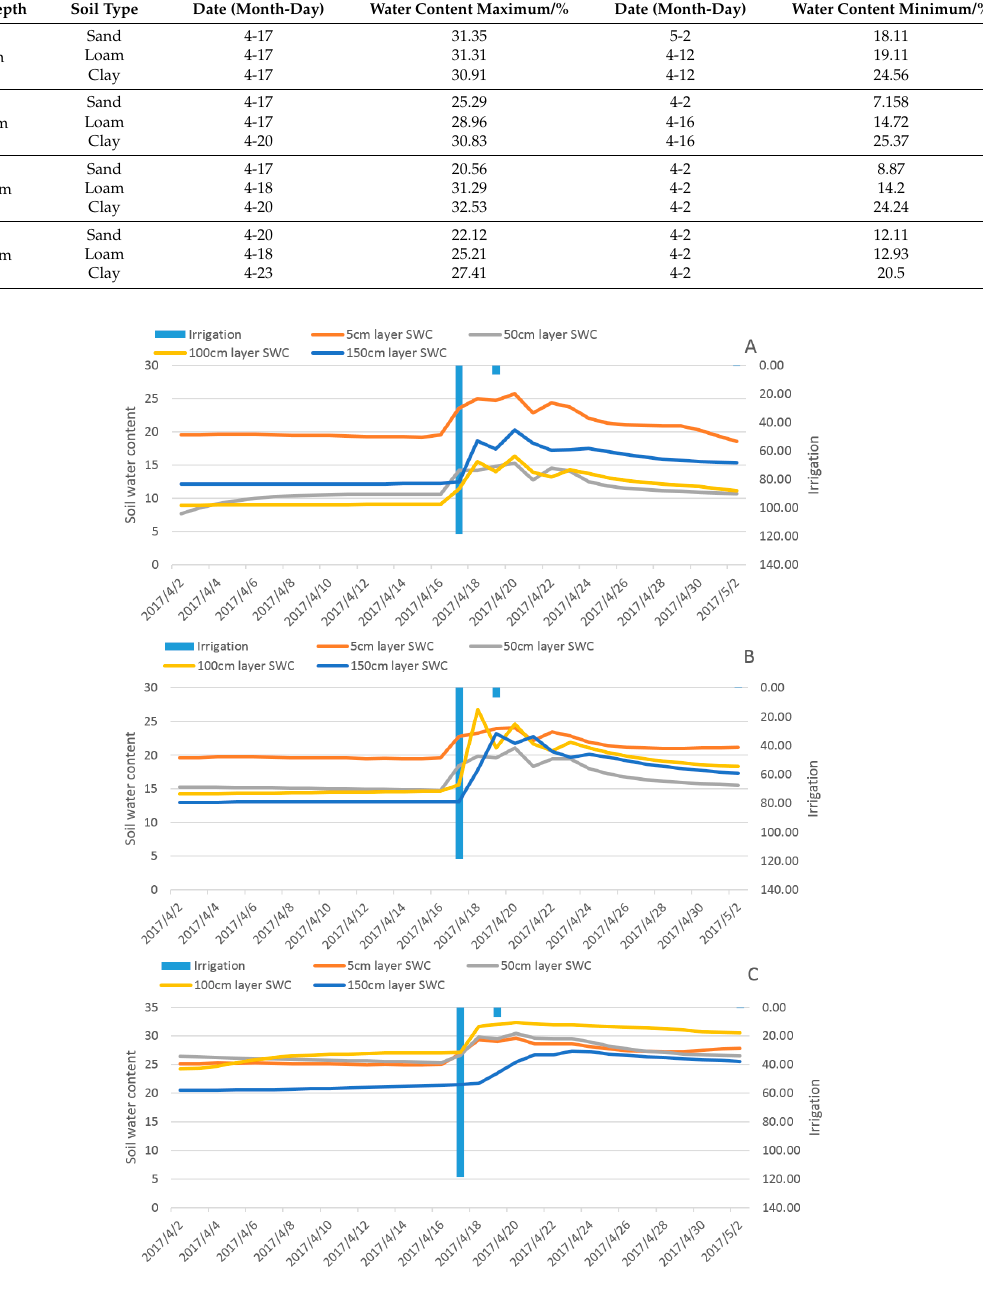
Table 2. Time change peak value of soil volume water content in the study site.